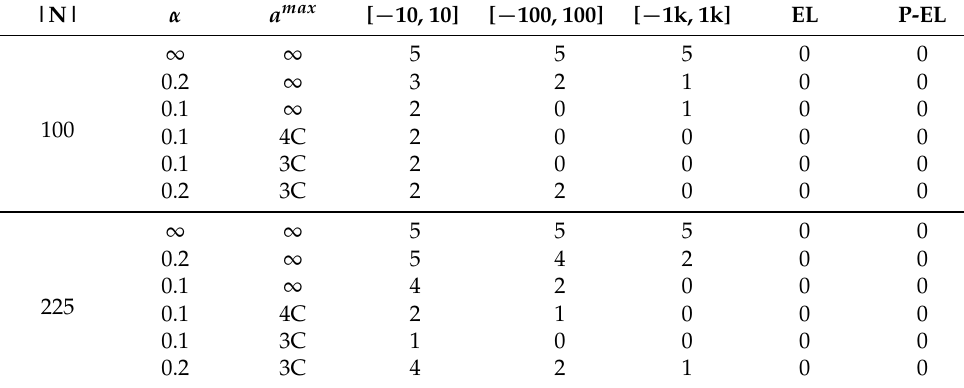
Table 8. Number of solutions with an objective function value equal to zero.